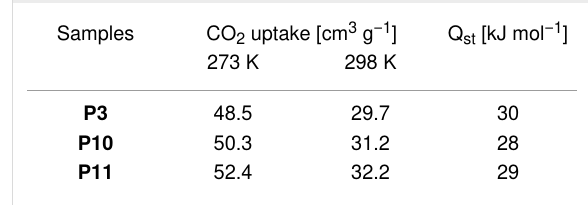
Table 4: CO 2 adsorption of P3 , P10 , and P11